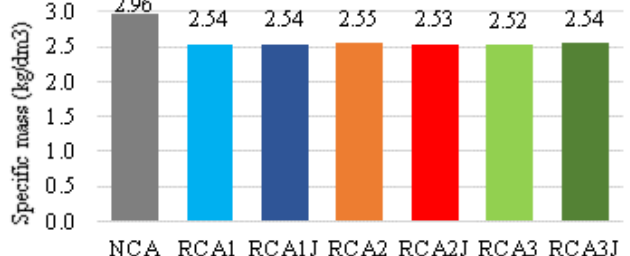
Figure 5. Specific mass of the recycled coarse aggregates from sources 1, 2 and